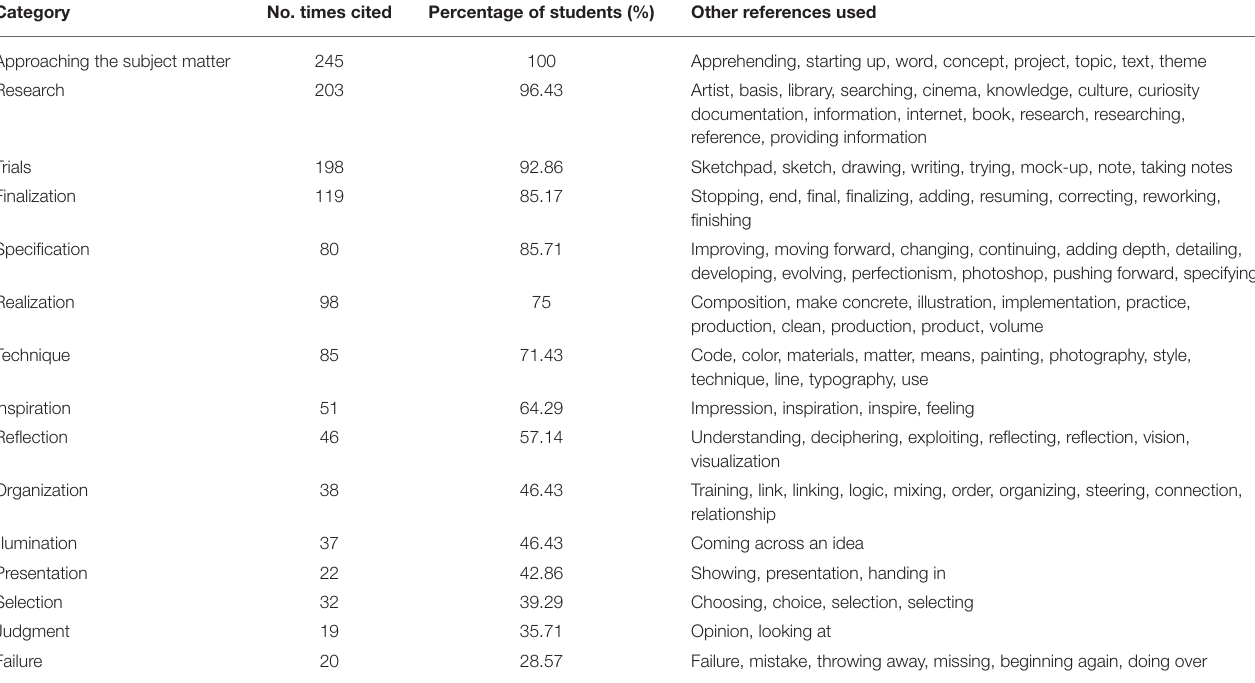
TABLE 2 | Categories of references used in the students’